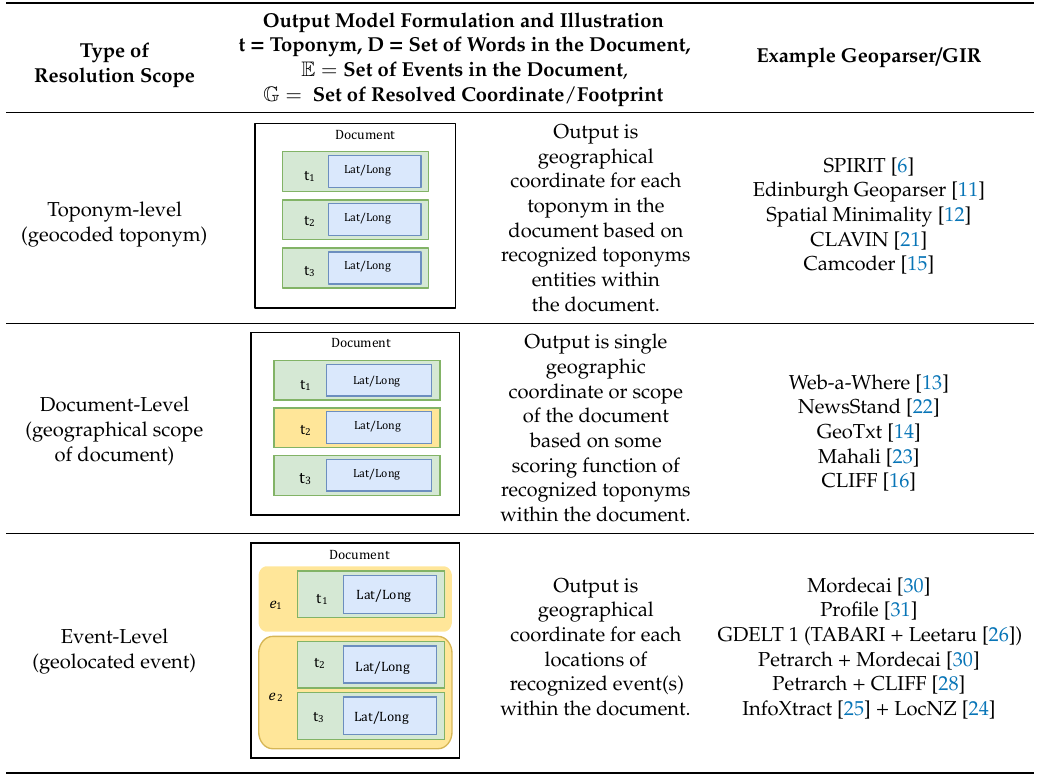
Table 1. Types of resolution scope of